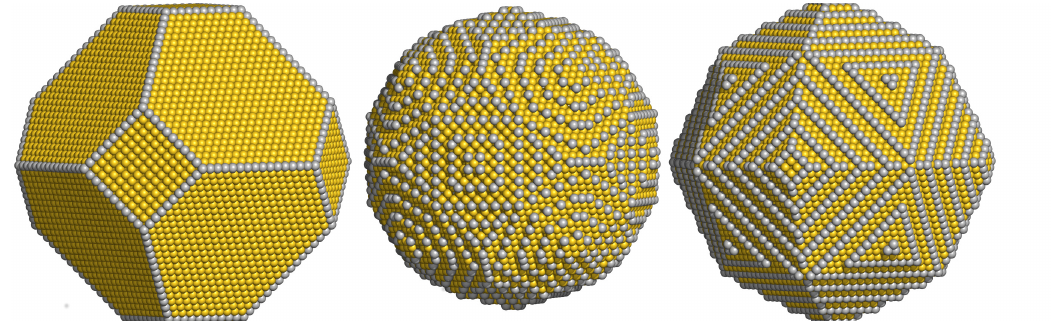
Figure 3. Ball-and-stick models of typical equilibrium shapes for Au nanoparticles. Step and kink atoms are shown in darker color. ( Left ): clean nanoparticle; ( center ): particle in CO-rich gas at typical CO oxidation conditions; ( right ): particle in equilibrium with thiol-containing molecules at typical polymer